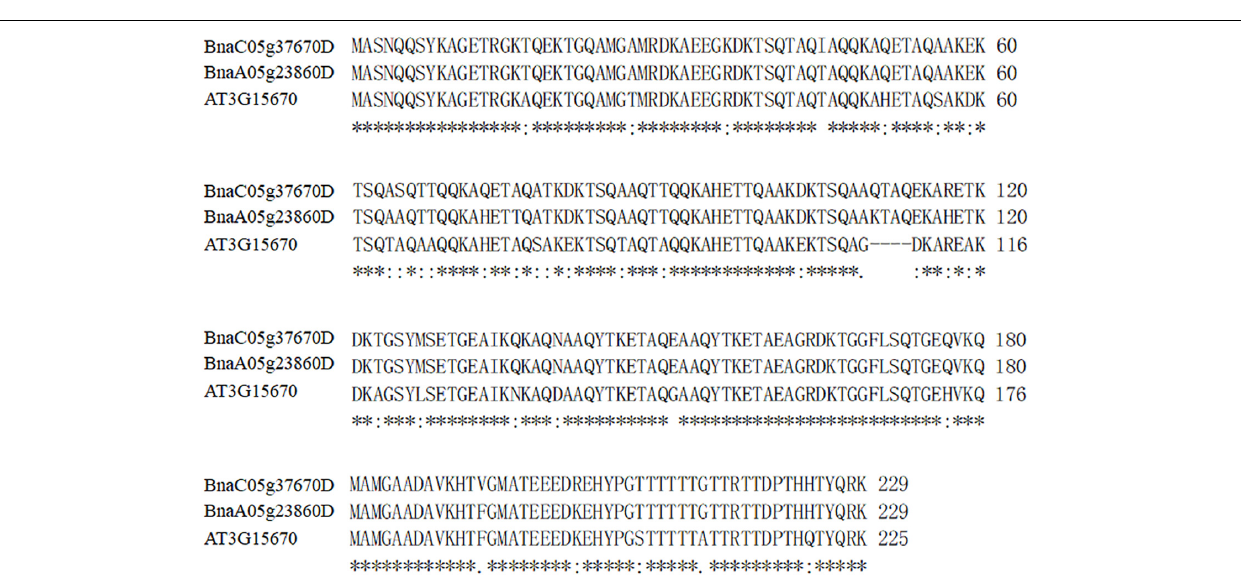
FIGURE 5 | Alignment of the amino acid sequences of BnLEA57 (BnaC05g37670D), BnLEA55 (BnaA05g23860D) and their Arabidopsis ortholog AtLEA76 (AT3G15670). Residues identical in all the three LEAs are denoted with an asterisk ( ∗ ), residues shared by two LEAs are indicated with a dot (.) or a colon